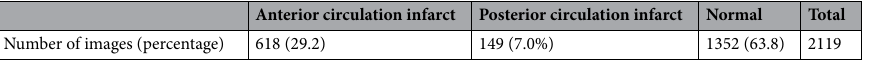
Anterior circulation infarct Posterior circulation infarct Normal Total Number of images Table 2. Dataset distribution.